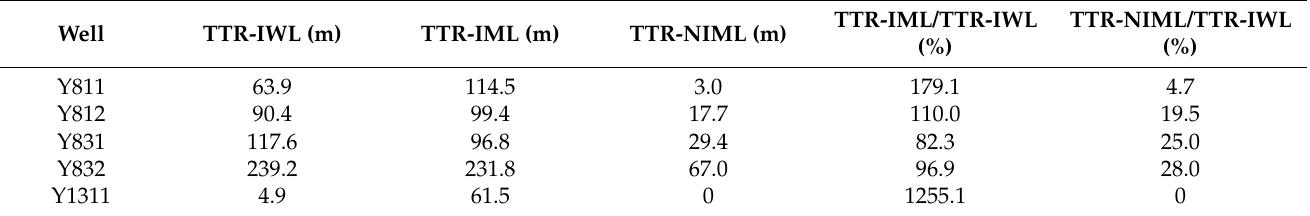
Table 1. Reservoir interpretation correlation between well-logging data and mud-logging data of intrusive rock buried-hill in the Y